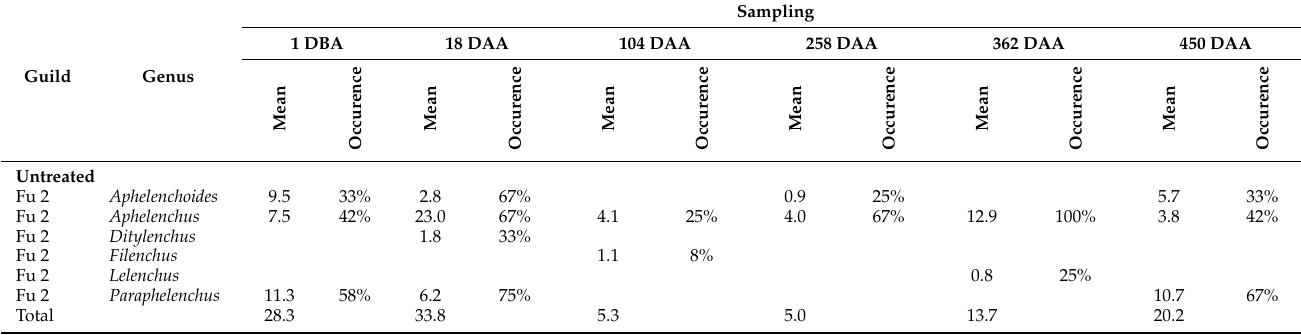
Table A3. Fungal feeding nematodes structure. Abundance and occurrence in trial variants during the study